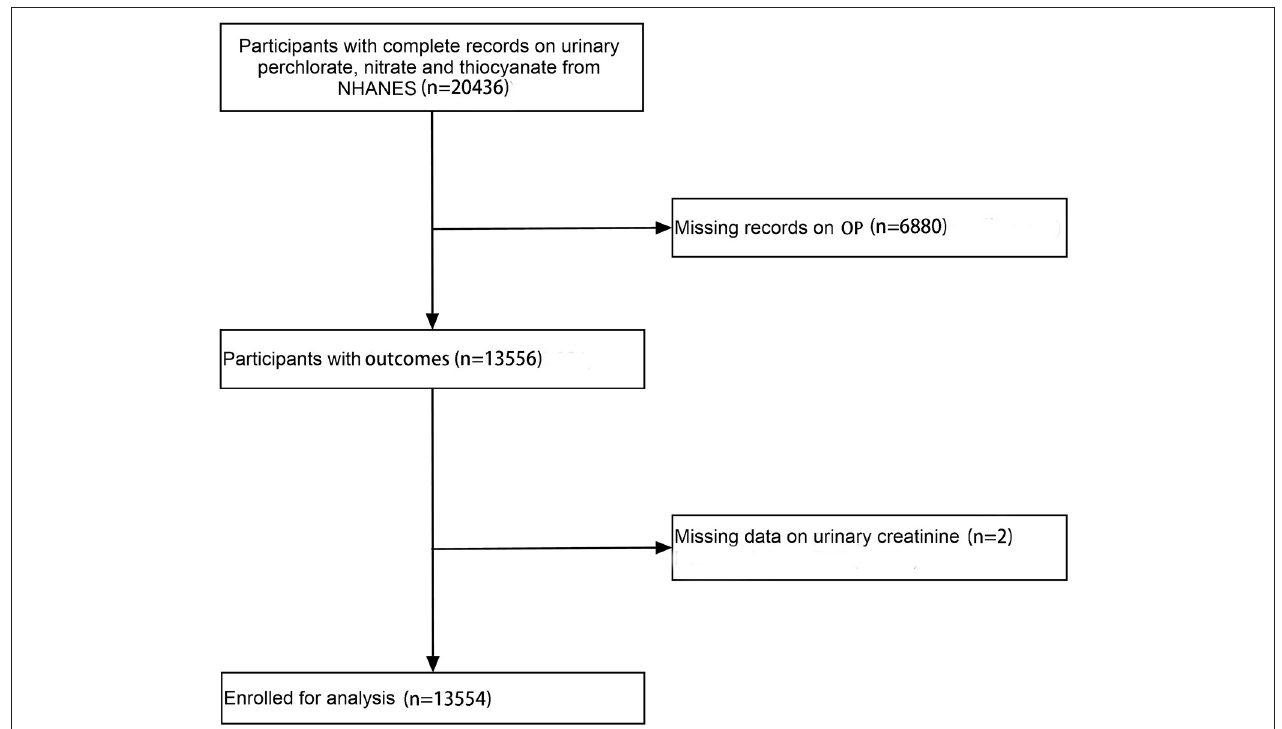
FIGURE 2 | The dose-response analysis between urinary thiocyanate with oral pain. The OR and their 95% CI were represented as association measure. The model was adjusted for creatinine, age, gender, race, education, PIR, BMI, drinking, smoking, activity, hypertension, diabetes, cardiovascular diseases, log 2 -transformed urinary perchlorate, and nitrate. The urinary thiocyanate was log 2 -transformed.